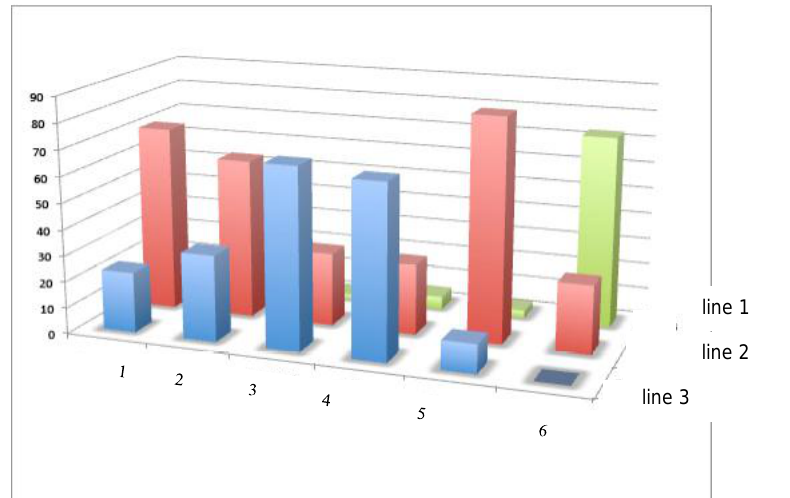
Fig.2. Graphic representation of mean squares’ relations (%).15 years old girls: line 1 — Х 1 (quantity of repetitions), line 2 — Х 2 (rest interval), line 3 — Х 1 Х 2 (interaction of quantity of repetitions and rest intervals) 1-Side roll, 2-Forward roll, 3-Backward roll, 4-Forced headstand, 5-Throw of small ball, 6-Long jump from